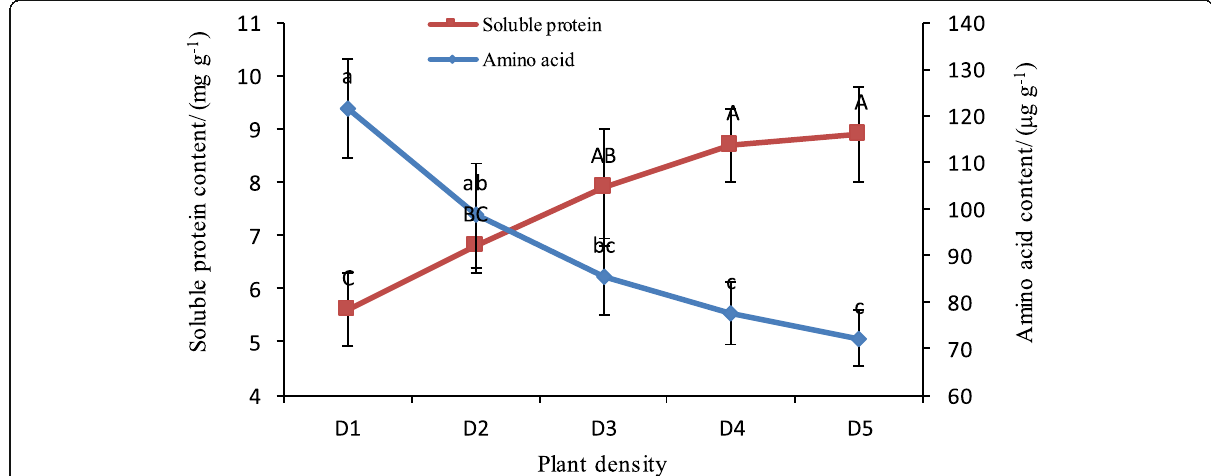
Fig. 2 The amino acid and soluble protein content in boll wall with different planting densities in 2018. D1-D5: 15000, 25 000, 45 000, 60 000, and 75 000 plants per hectare. The vertical bar represents S.E. of the mean ( n = 3) when the value exceeds the size of the symbol. Minuscule letters indicate significance analysis among amino acids, and capital letters indicate significance analysis among soluble proteins. The same letter among treatments is not significantly different ( P <